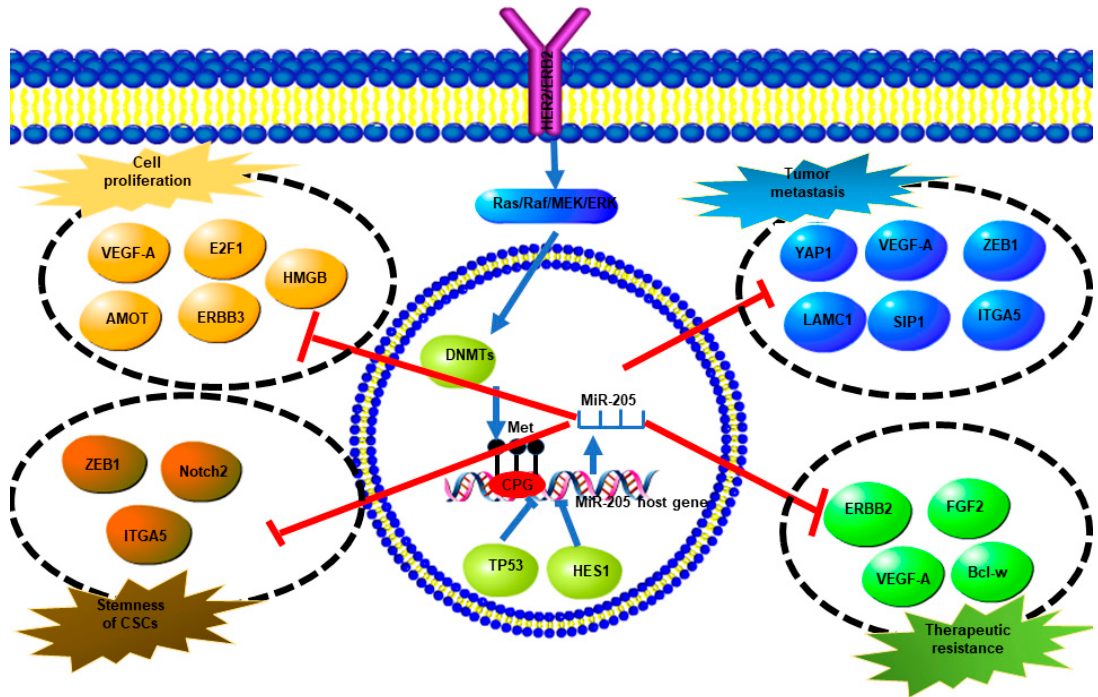
Figure 4. A summary of miR-205-5p expression regulation and direct targets of miR-205-5p and their biological effects. Overexpression of ERBB2 promotes methylation of the miR-205-5p promoter via the Ras/Raf/MEK/ERK pathway which upregulates DNMTs, which finally results in miR-205-5p downregulation. TP53 and HES also inhibit miR-205-5p expression. MiR-205-5p targets different genes directly to regulate cell proliferation, tumor metastasis, stemness, and therapeutic resistance. Table 1. A summary of the validated direct targets of miR-205-5p in breast cancer.